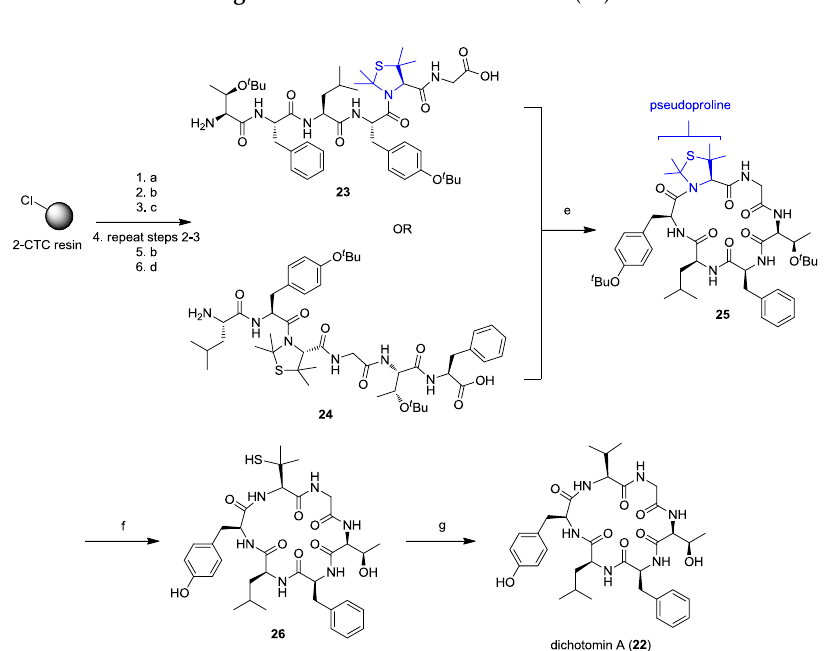
Figure 5. Structure of dichotomin A ( 22 ).